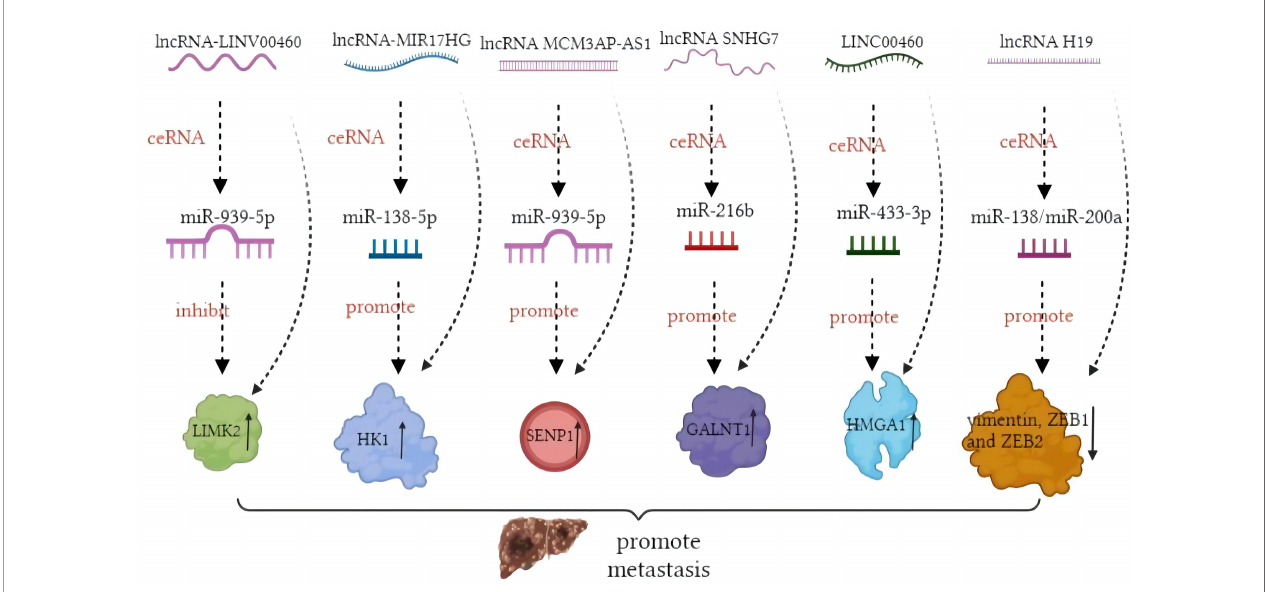
FIGURE 1 | Mechanism of long non-coding RNAs (lncRNAs) acting as competing endogenous RNAs (ceRNAs) in colorectal cancer (CRC)